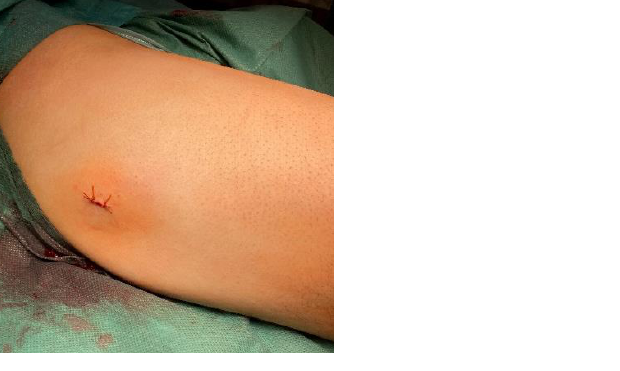
Figure 7. Postoperative condition in the operating room: an approximately 2-centimeter incision.